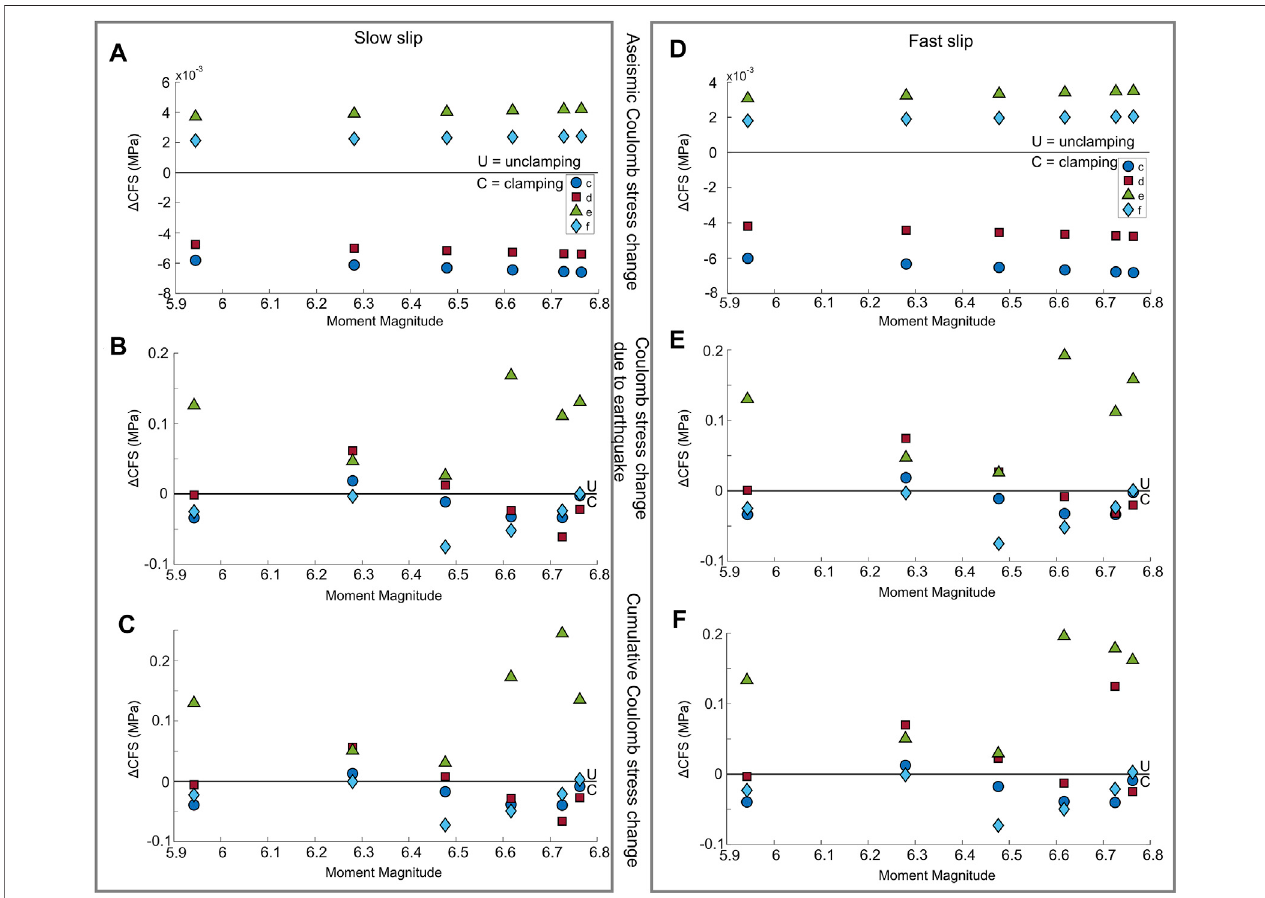
FIGURE5| Sameas Figure4 butformodeledCoulombfailurestresschangesonpointprobesc,d,eandfonHasanDa ğ ’ smagmareservoir(seealso Figure2B ). Tangents of c and d are parallel to the AKFS while tangents on e and f are perpendicular to it. (A,D) show the Coulomb failure stress changes on the points due to the gradual stress accumulation prior to hypothetical earthquakes with given moment magnitude. (B,E) show the Coulomb failurestresschanges asa result of hypothetical earthquakes with given SRL. (C,F) show the cumulative Coulomb failure stress changes. (A – C) for 0.58 mm yr − 1 right-lateral slip and 0.0536 mm yr − 1 of normal slip (labeled slow slip). (D – F) for 3.35 mm yr − 1 right-lateral slip and 0.0536 mm yr − 1 of normal slip (labeled fast slip).